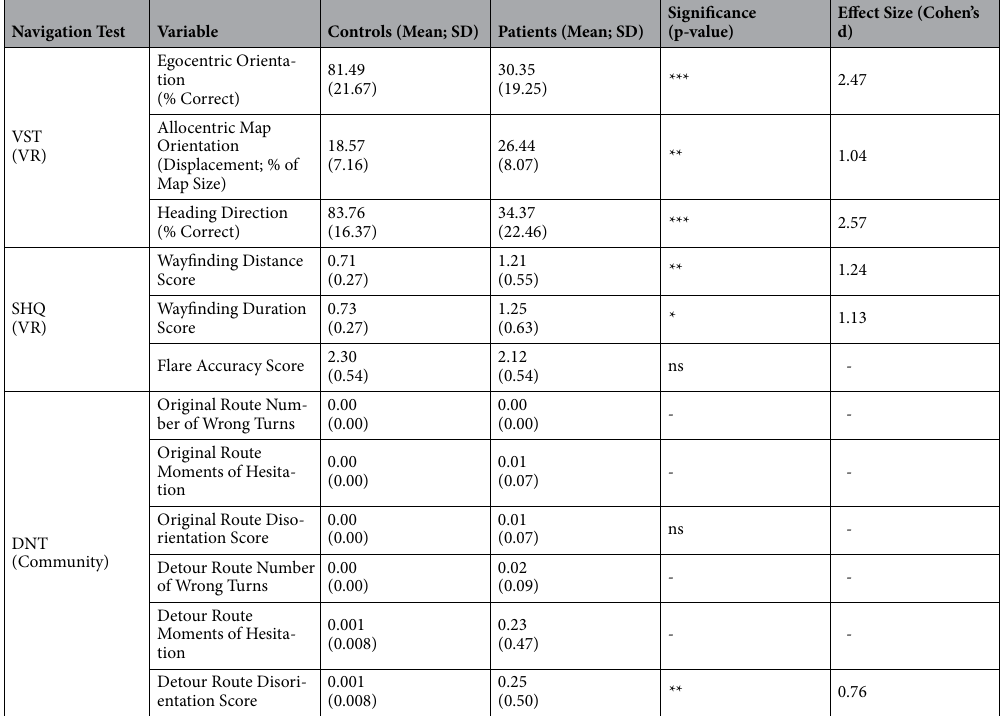
Table 2. Overview of Group Differences in VR/Community Navigation Variables. * p < 0.05, ** p < 0.01, *** p < 0.001, ns = not